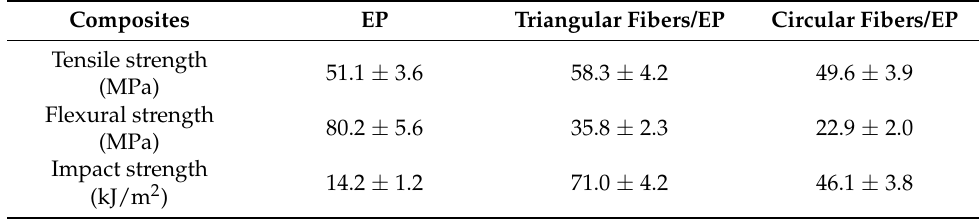
Table 1. The mechanical strength averages of EP and PVA/EP composites with different